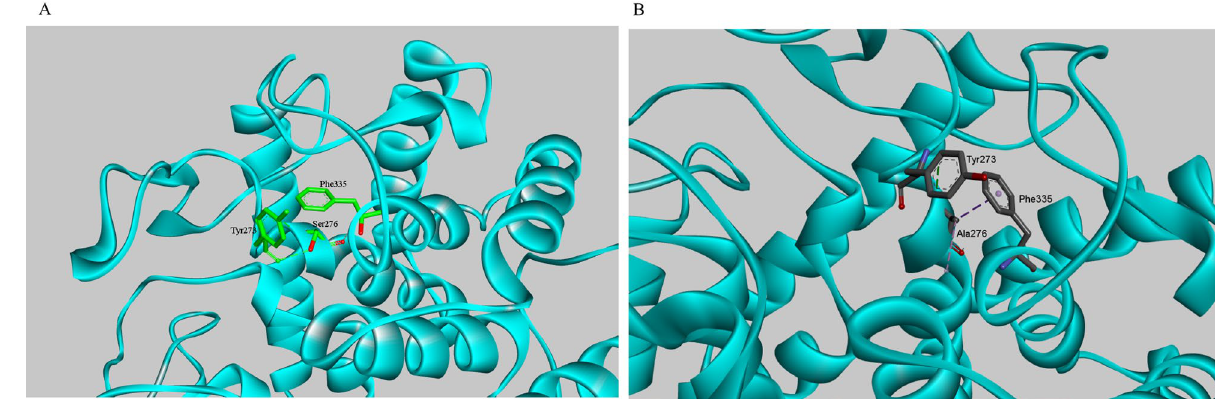
Figure 5. Changes of intramolecular interactions of residue 276 with the nearby residues after S276A mutation. The intramolecular interactions were displayed with Discovery Studio 4.1. The proteins are shown in cyan. The residue Ser276 is shown in green and Ala276 is shown in gray according to the stick representation scheme. The dotted line corresponds to the intramolecular interactions. ( A ) Wild-type. ( B )